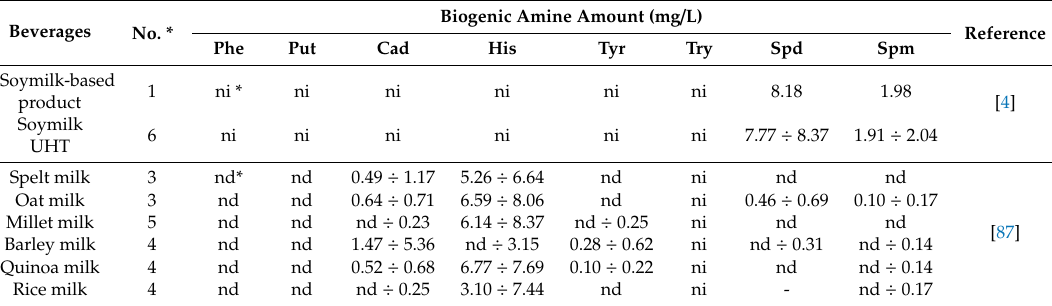
Table 3. Biogenic amine amount for plant